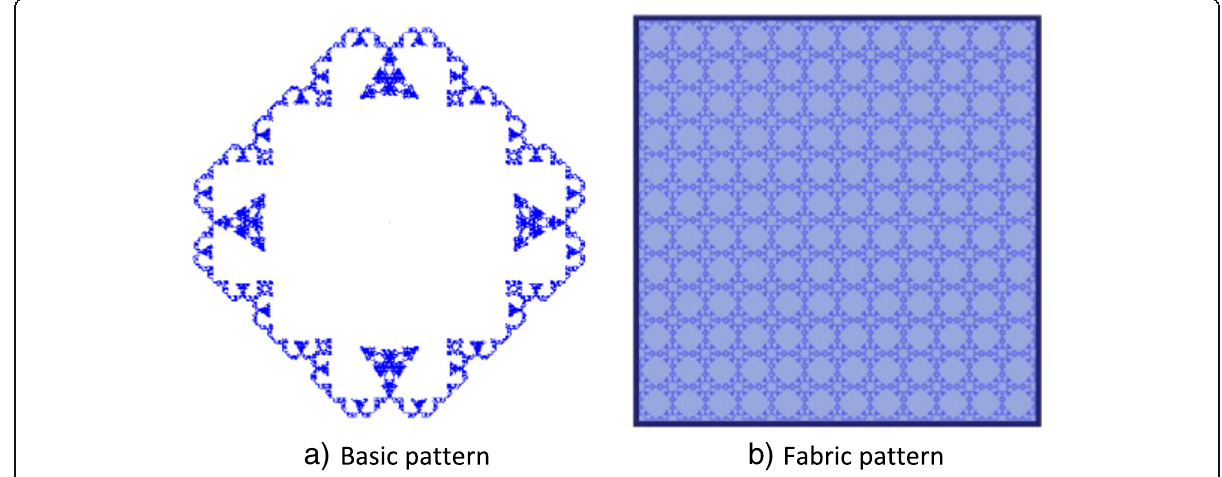
Fig. 16 Printing pattern design of garment fabrics